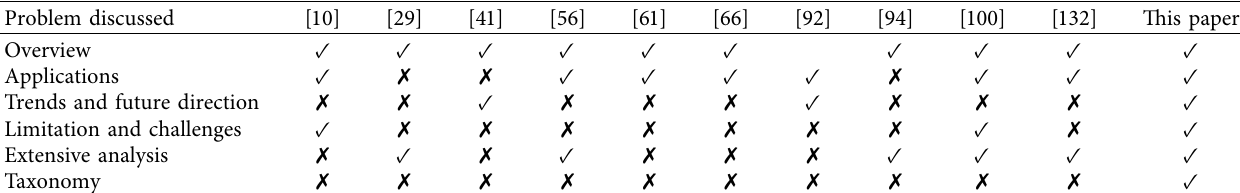
Table 7: Comparison of this study to other